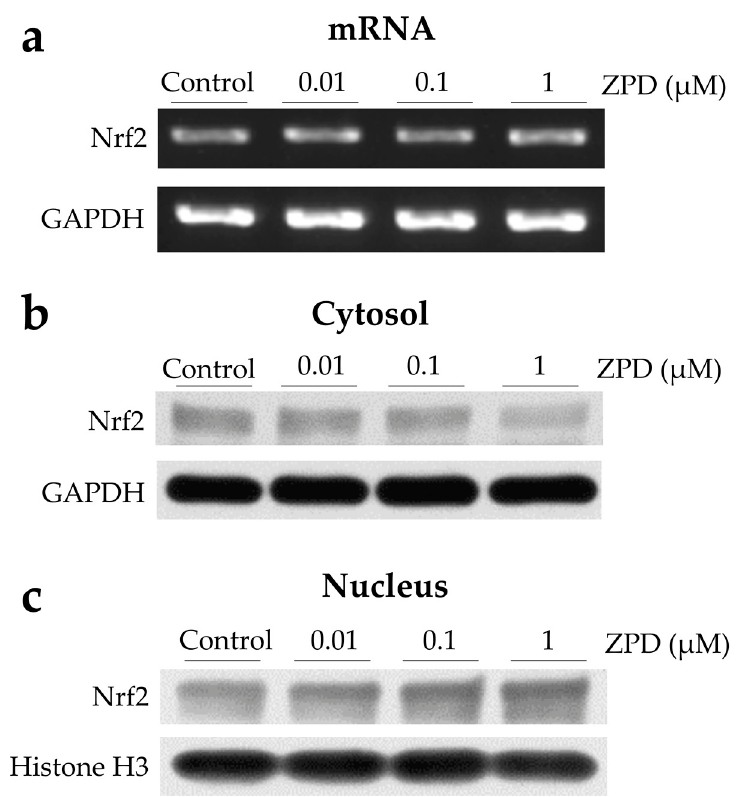
Figure 2. Ziprasidone (ZPD) enhanced nuclear translocation of Nrf2 in differentiated PC12 cells in a dose-dependent manner. Cells were treated with 0.01, 0.1, and 1 µ M ZPD for 24 h. Glyceraldehyde 3-phosphate dehydrogenase (GAPDH) and histone H3 were used as internal standards. ( a ) Representative semiquantitative RT-PCR analysis of Nrf2 mRNA expression in differentiated PC12 cells. ( b , c ) Western blot analysis of the effect of ZPD on cytoplasmic (b) and nuclear (c) expression of Nrf2 protein. Abbreviations: Nrf2, NF-E2-related factor-2; RT-PCR, reverse transcription polymerase chain reaction.